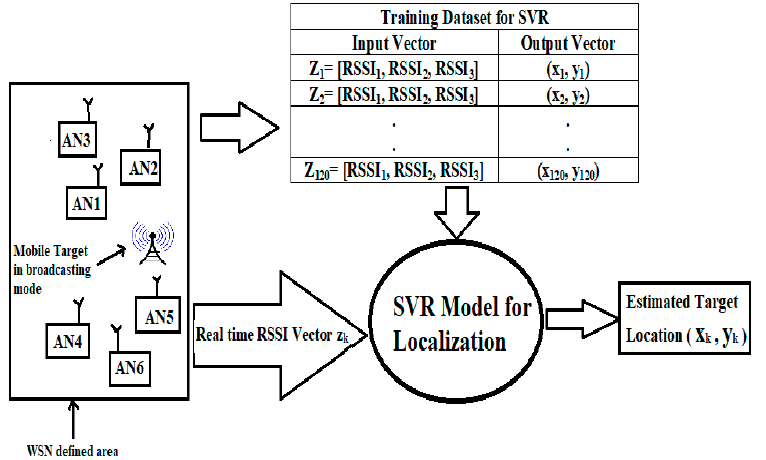
Figure 1. System block diagram for the proposed SVR-based target-localization scheme.